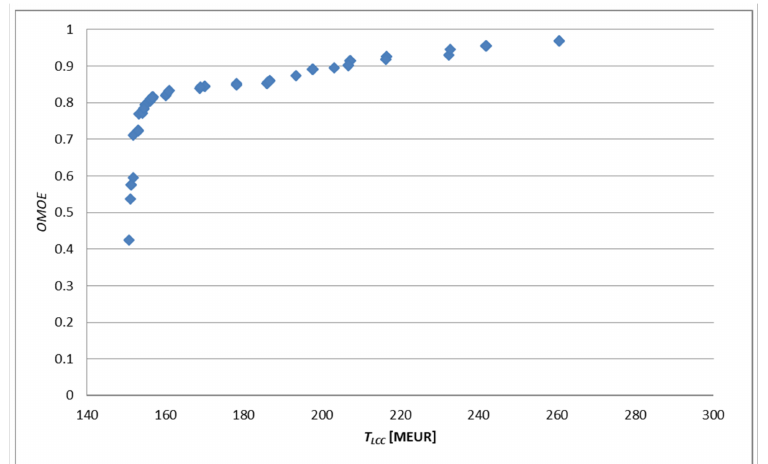
Figure 2. Pareto optimal set of solutions (blue squares) for hybrid OPV as a standard OPV.